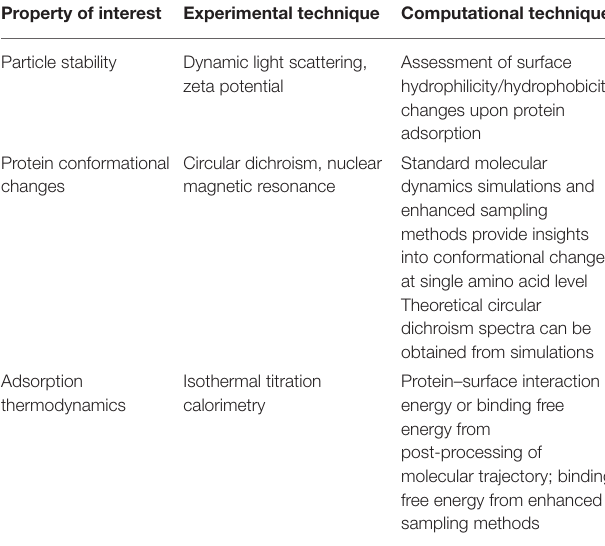
TABLE 2 | Reference experimental and computational techniques for properties of interest of the protein corona. Property of interest Experimental technique Computational technique Particle